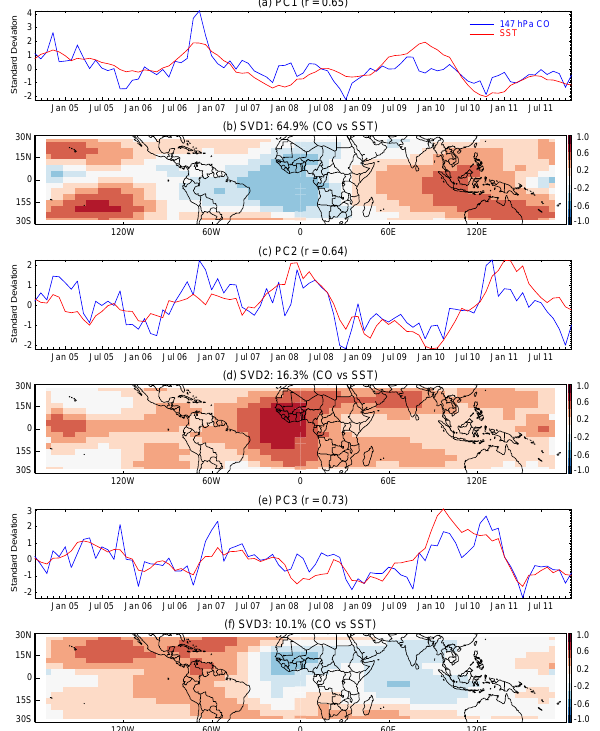
Fig. 5. SVD analysis results of 147hPa CO and SST for the period of August 2004–December 2011: (a) principle components (PCs) of 147hPa CO (blue) and SST (red) for the first SVD mode, (b) heterogeneous correlation map of 147hPa CO (i.e., correlation be- tween 147hPa CO and the PC of SST) for the first SVD mode, (c) PCs of 147hPa CO (blue) and SST (red) for the second SVD mode, (d) heterogeneous correlation map of 147hPa CO for the second SVD mode, (e) PCs of 147hPa CO (blue) and SST (red) for the third SVD mode, and (f) heterogeneous correlation map of 147hPa CO for the third SVD mode.